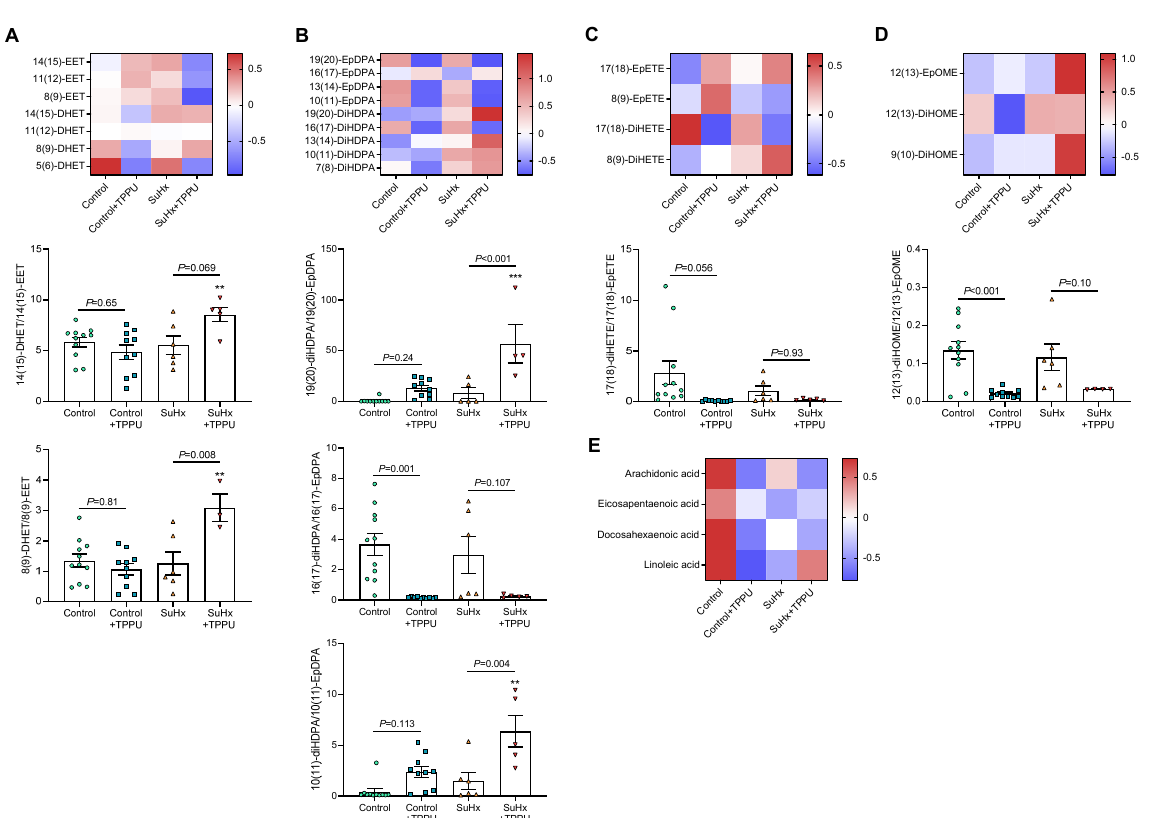
Figure 5. Z-score heat maps of plasma levels and diol-to-epoxide ratios of epoxyeicosatrienoic acid (EET) and dihydroxyeicosatrienoic acid (DHET) regioisomers ( A ); epoxydocosapentaenoic acid (EpDPA) and dihydroxydocosapentaenoic acid (DiHDPA) regioisomers ( B ); eicosatetraenoic acid (EpETE) and dihydroxytetraenoic acid (DiHETE) regioisomers ( C ); epoxyoctadecenoic acid (EpOME) and dihydroxyoctadecenoic acid (diHOME) regioisomers ( D ); and plasma levels of their respective precursors, i.e., arachidonic acid, docosahexaenoic acid, eicosapentaenoic acid, and linoleic acid ( E ), obtained in normoxic control rats and in rats receiving Sugen 5416 associated with 3-week hypoxia (SuHx) treated with vehicle or with the soluble epoxide hydrolase inhibitor TPPU. Data were obtained from the same series of animals as presented in Figure 4. Only statistically significant diol-to-epoxide ratios are shown ( p < 0.05, ANOVA). ** p < 0.01 and *** p < 0.001 vs. corresponding control rats.